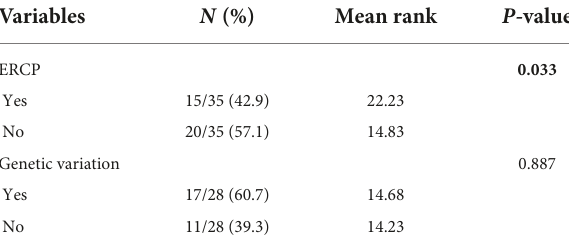
TABLE 4 Relationship between pancreatic division and rapid progression of CP in